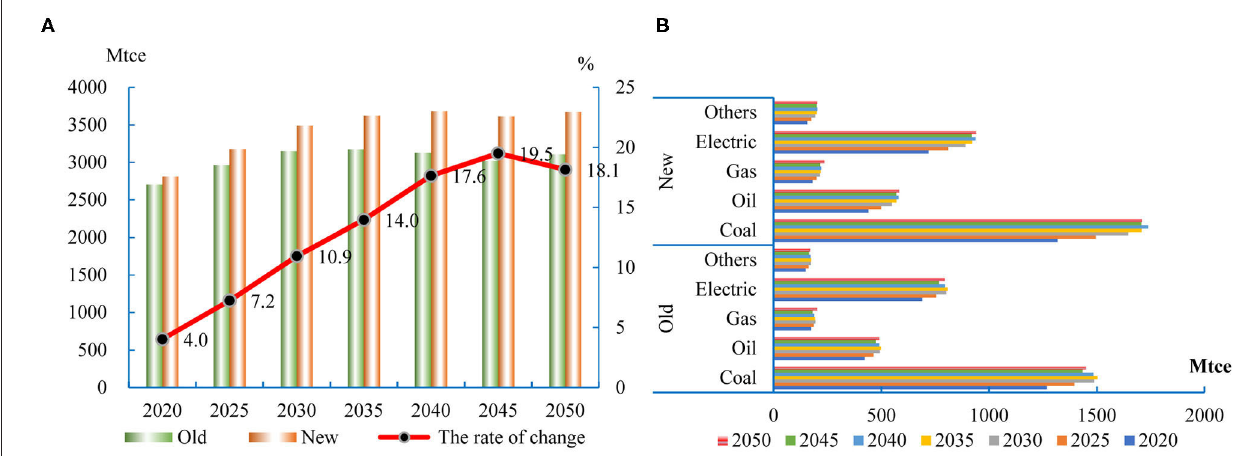
FIGURE 5 | The energy consumption in the industrial and commercial sectors. (A) The changes of energy consumption in industrial and commercial sectors. (B) The changes of different energy